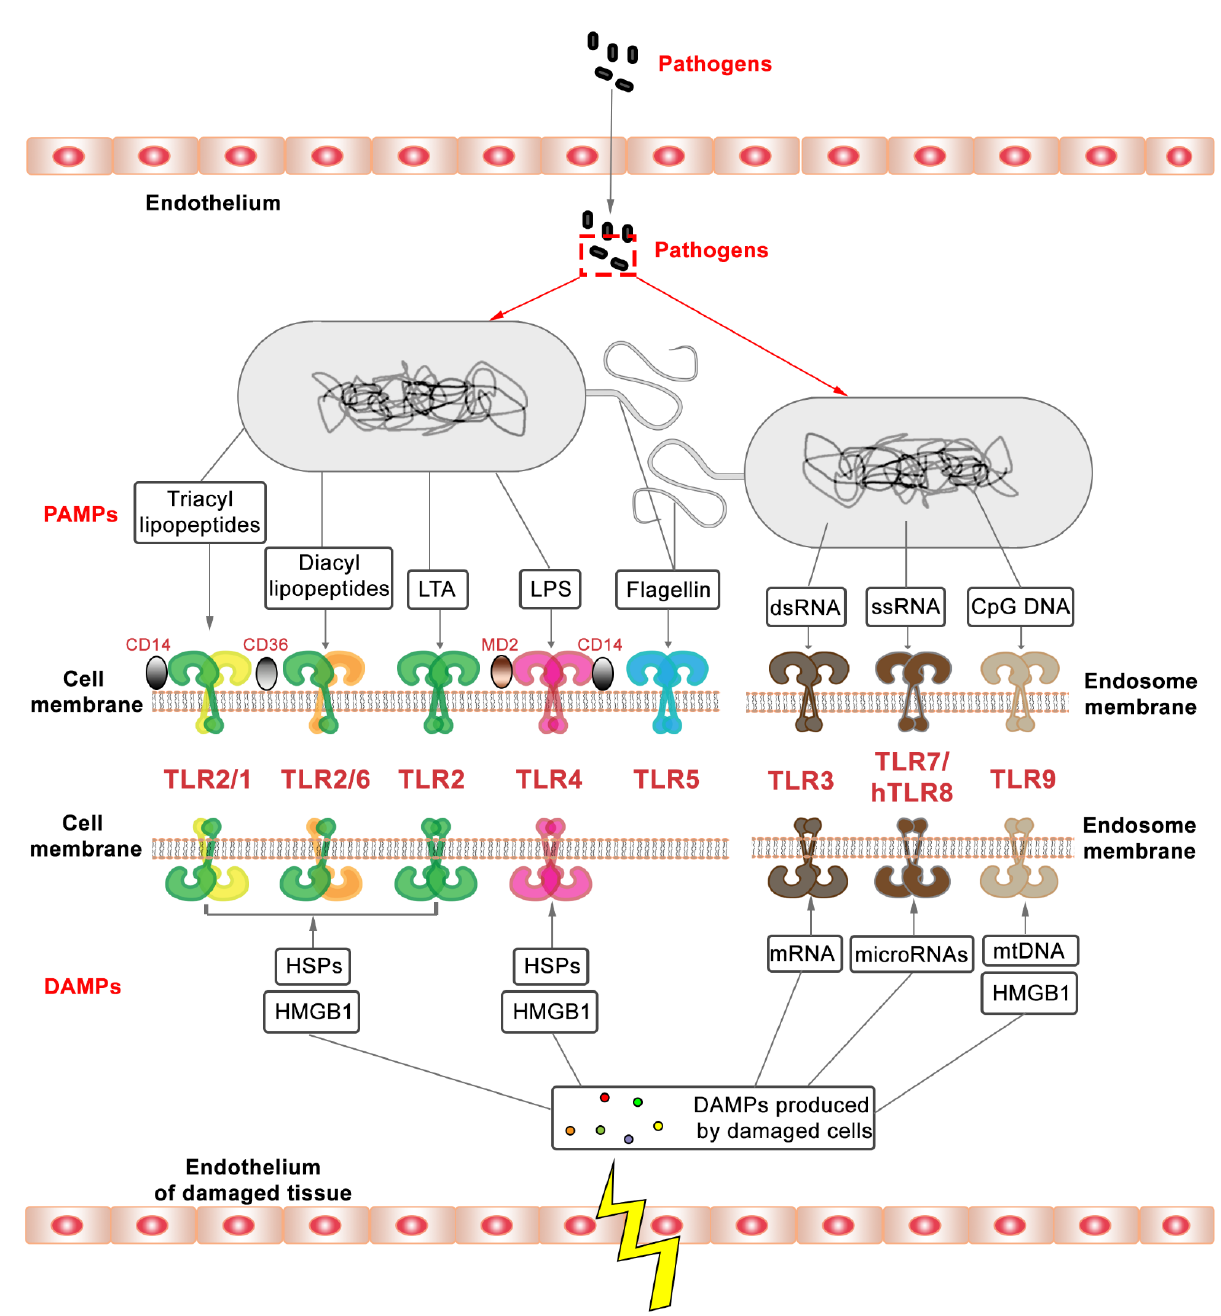
Figure 2. TLRs and their ligands. TLRs can recognize PAMPs from invading microbial pathogens and DAMPs from infected or damaged tissue. TLR2, its heterodimers, and TLR4 recognize patho- gens through their cell wall surface components. TLR2 dimerizes with TLR1 or with TLR6 to sense triacyl or diacyl lipopeptides, and lipoteichoic acid (LTA) on the cell wall of Gram-positive bacteria and mycobacteria [37 – 40]. The process of the recognition of triacyl or diacyl lipopeptides by heter- odimers requires the participation of accessory molecules. For example, CD14 and CD36 are well characterized as ligand delivery molecules that enhance TLR2 responses to ligands especially with a lower concentration of ligands, although the participation of these molecules is not essential [39,40]. TLR4 senses Gram-negative bacteria through the lipopolysaccharide (LPS) located on their